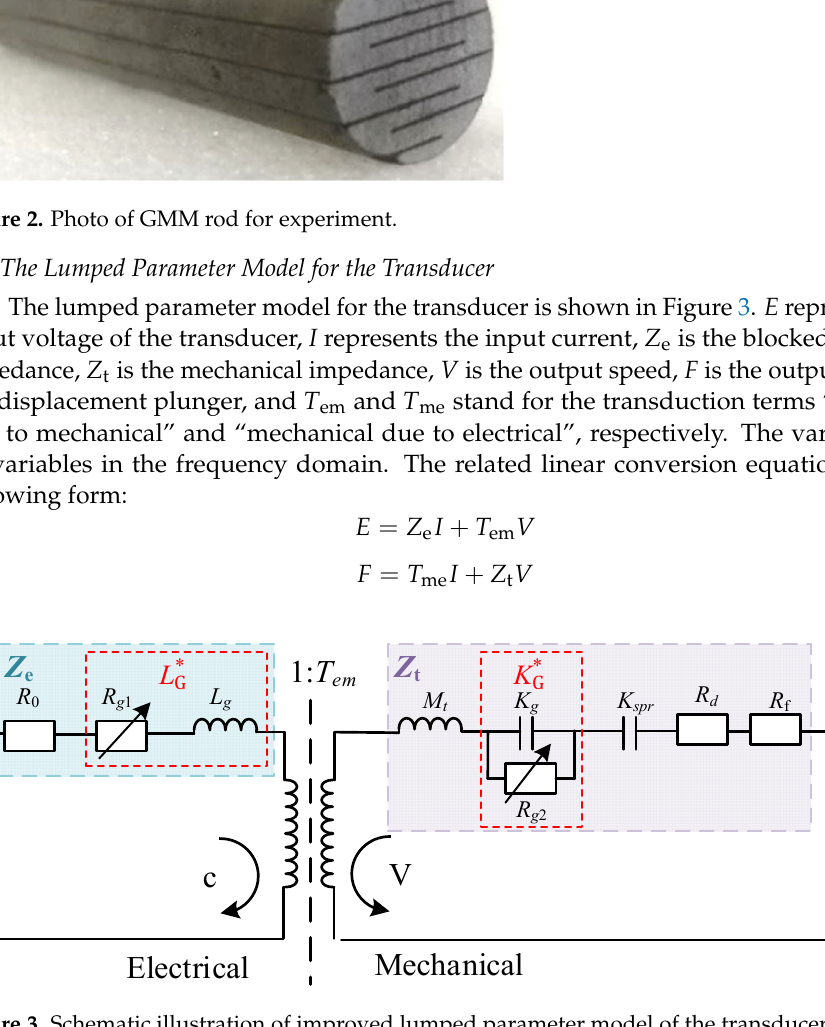
Figure 3. Schematic illustration of improved lumped parameter model of the transducer.